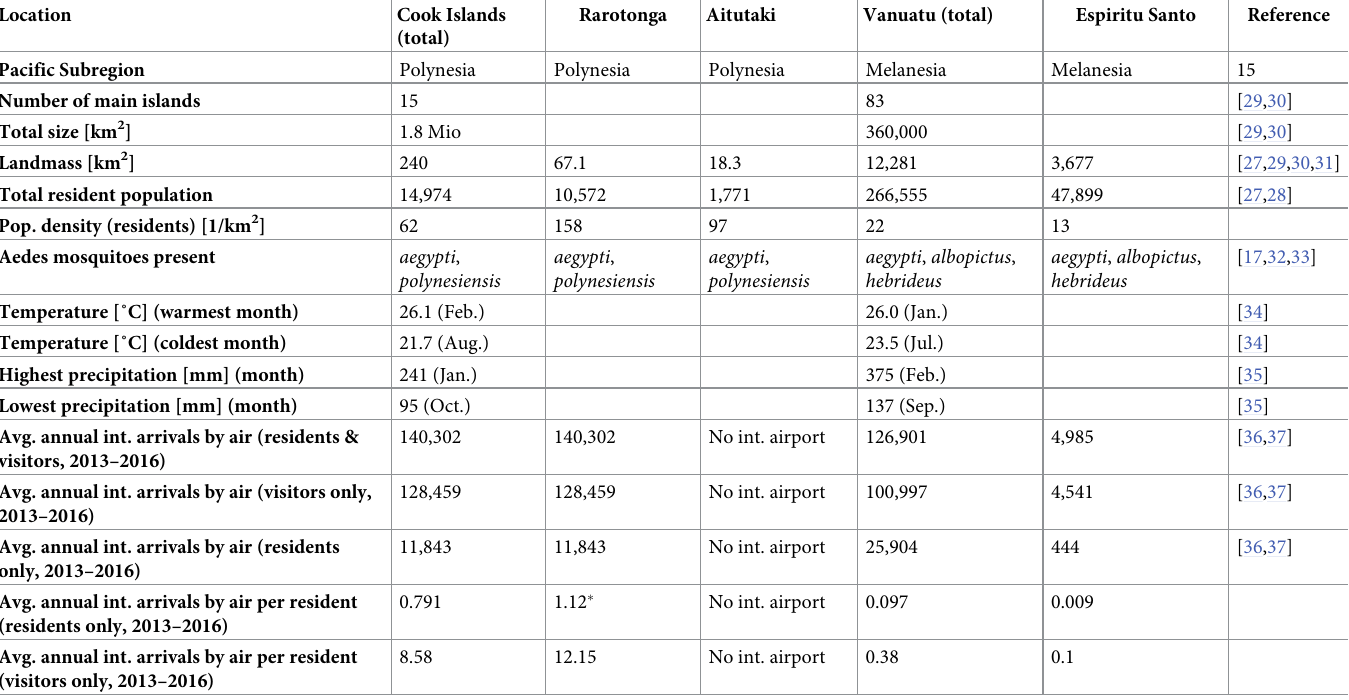
Table 1. Environmental and social data of epidemiological relevance in the study sites.